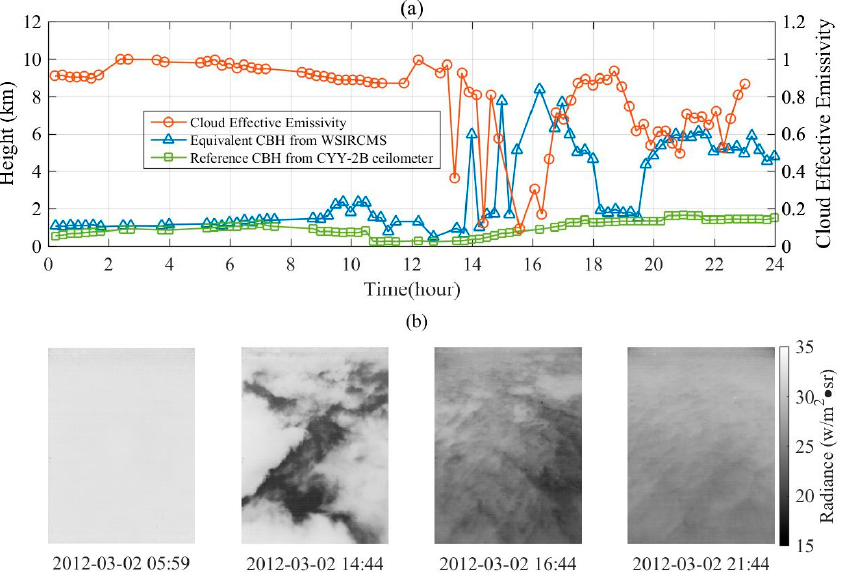
Figure 5. Example of cloud effective emissivities derived from the joint observation ( a ) and corresponding images showing the zenith sky at 05:59, 14:44, 16:44, and 21:44 LT (from left to right) ( b ) at the CMA Beijing Observatory Station for 2 March 2012.